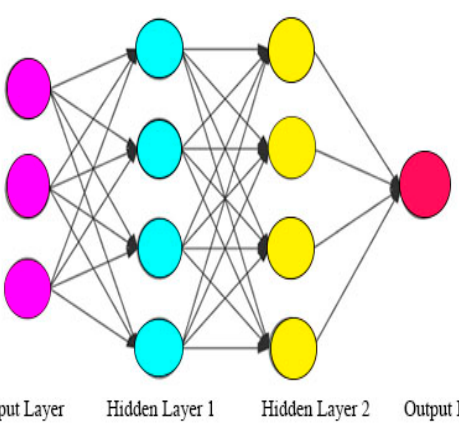
Figure 4. Multi-Layer Perceptron Figure 4. Multi ‐ Layer Perceptron model .